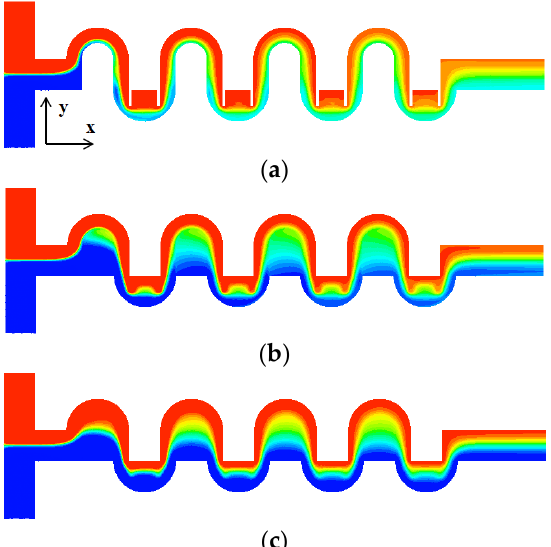
Figure 14. Concentration distribution on three planes for W s = 60 μ m and Re = 0.1: ( a ) At z = 30 μ m, ( b ) At z = 60 μ m, and ( c ) At z = 90 μ m.